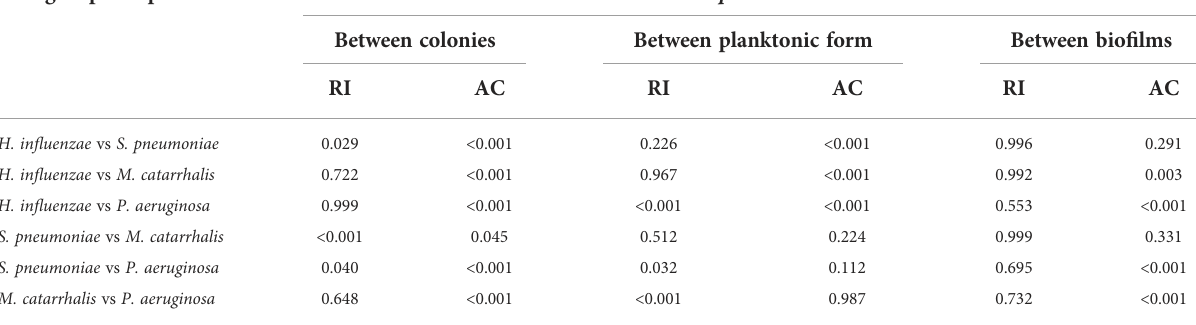
TABLE 5 Intra-group comparison of p-values among colonies, planktonic form, and bio fi lms by one-way ANOVA with post-hoc Tukey ’ s HSD test. Intergroup